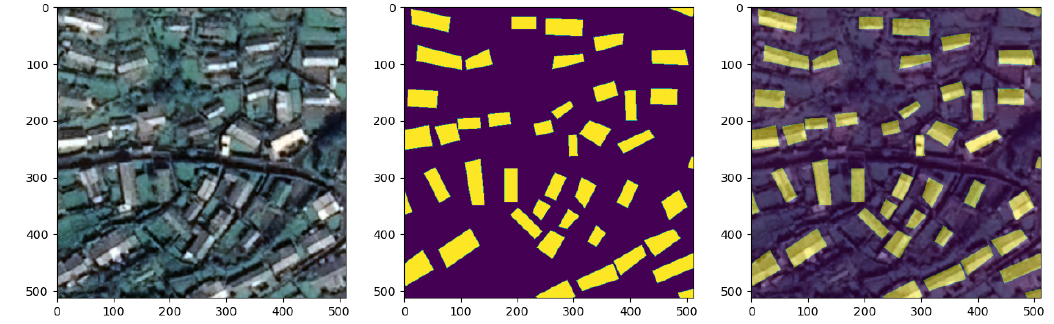
Figure 6. An example image of the EA